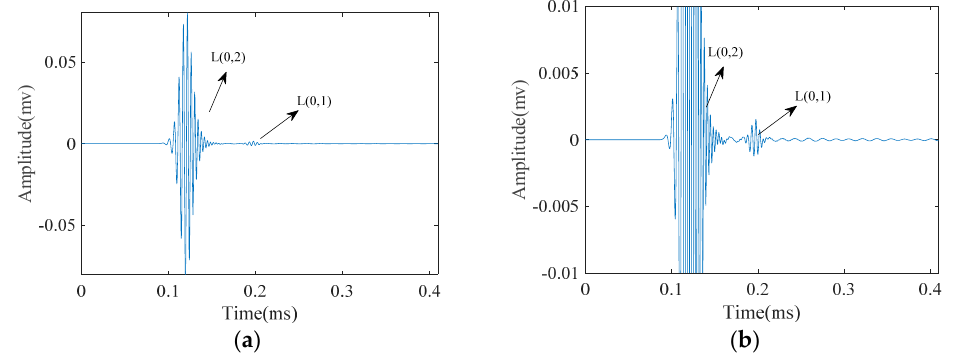
Figure 3. Longitudinal guided wave modes emitted at a 220 kHz center frequency as a five-cycle tone-burst signal into: ( a ) a pipe; and ( b ) the zoomed wave signal.